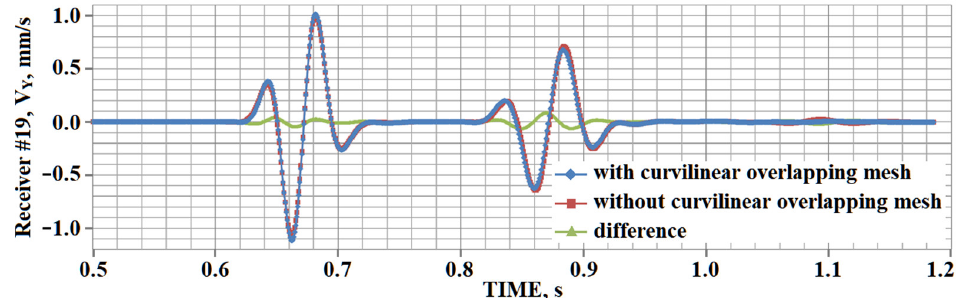
Figure 20. Receiver #19, dependencies of Y-component of velocity on time.